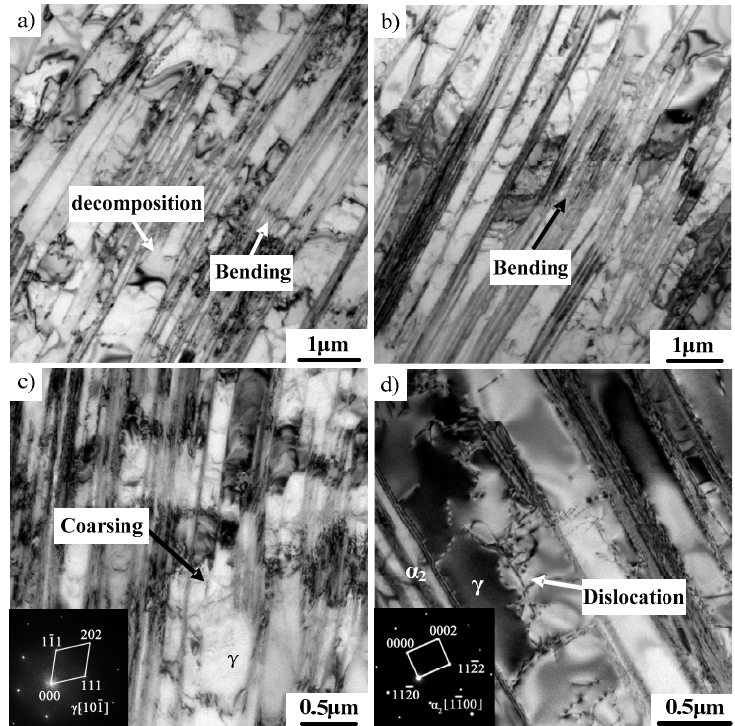
Figure 6. TEM images showing the microstructure of the Ti–43Al–2Cr–2Mn–0.2Y alloy after 20% deformation. ( a , b ) Bended lamellae, ( c ) coarsening of lamellae, ( d ) dislocations.